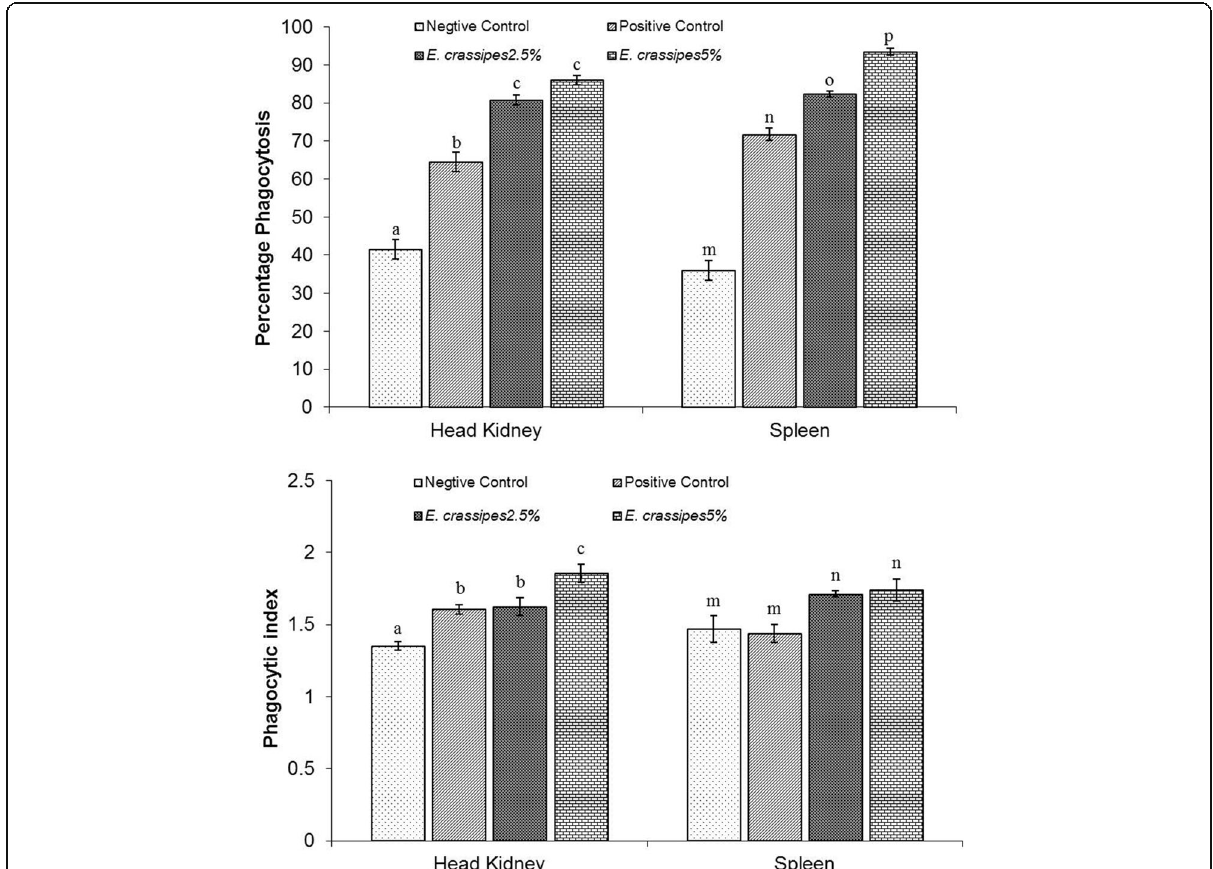
Fig. 3 Phagocytic activity of macrophages isolated from the spleen and head kidney of Channa punctata: a percentage phagocytosis and b phagocytic index. Values are expressed in mean ± SEM. p values are calculated using one-way ANOVA followed by Student Newman-Keuls ’ multiple range test. p values ≤ 0.05 considered as significantly different. Error bars with dissimilar superscripts differ